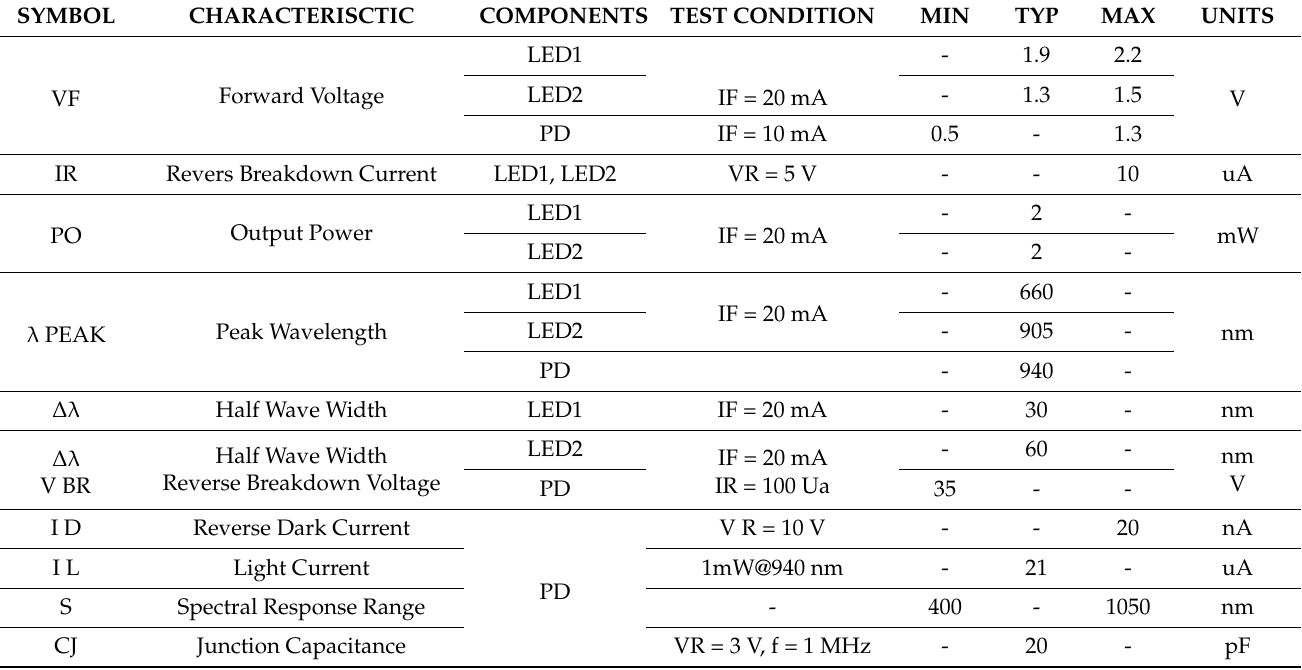
Figure 6. Illustration of the radial artery and sensing array location. Table 2. The datasheet of